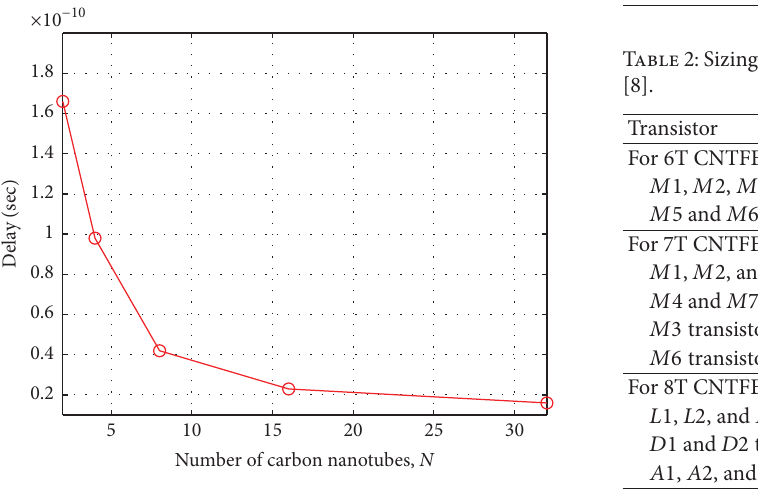
Figure 6: Effect of CNT number on the delay.